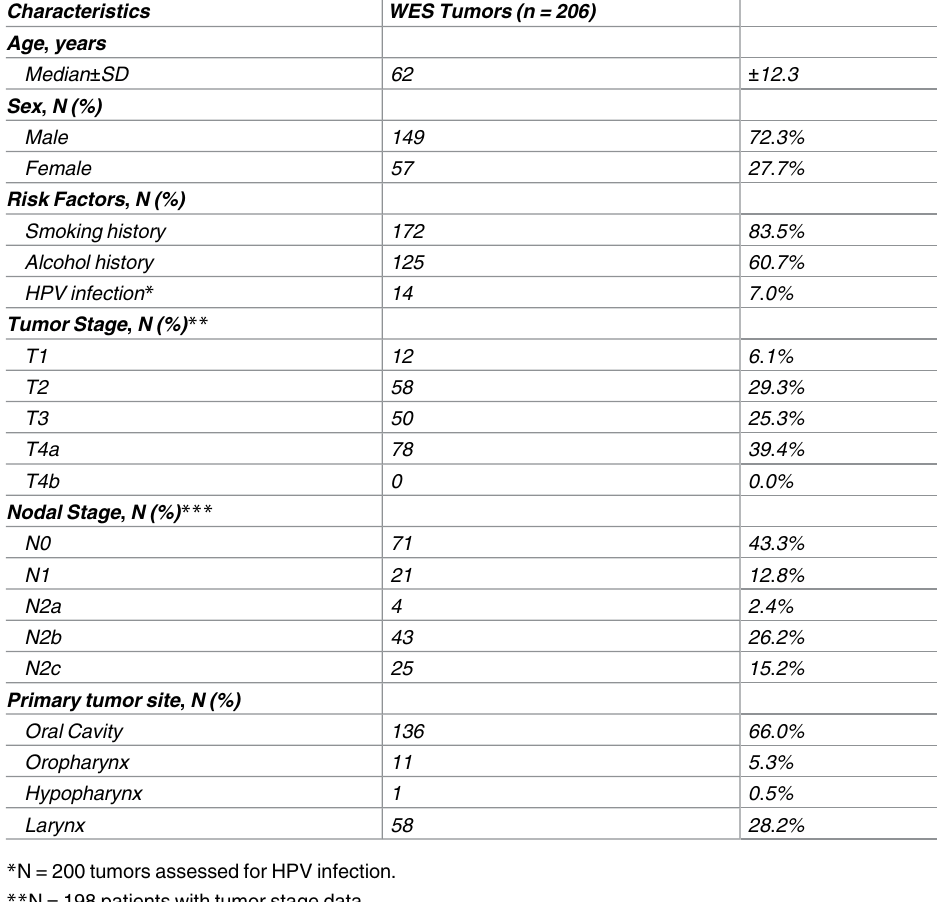
Table 1. Patient characteristics of 206 HNSCC tumors with RPPA and WES results.